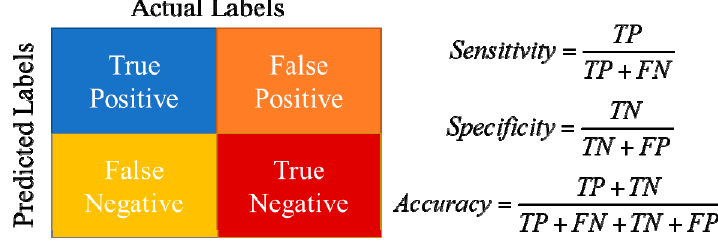
Figure 16. Confusion matrix for evaluating of the proposed indicators.